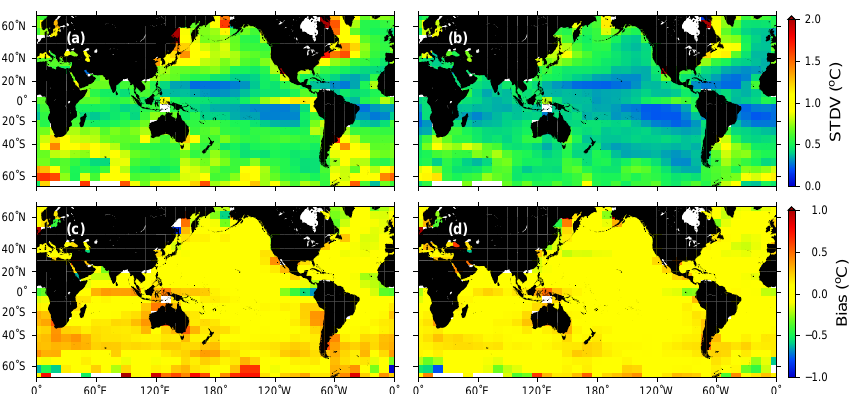
Figure 7. Distributions of standard deviation and bias of the satellite-based blended (infrared + microwave) foundation SST in this study. ( a ) Standard deviation of the low-frequency part; ( b ) standard deviation of the combination of low- and high-frequency parts; ( c ) bias of the low-frequency part; and ( d ) bias of the combination of low- and high-frequency parts. The statistics were obtained by comparisons with 2003–2015 drifting buoy measurements.